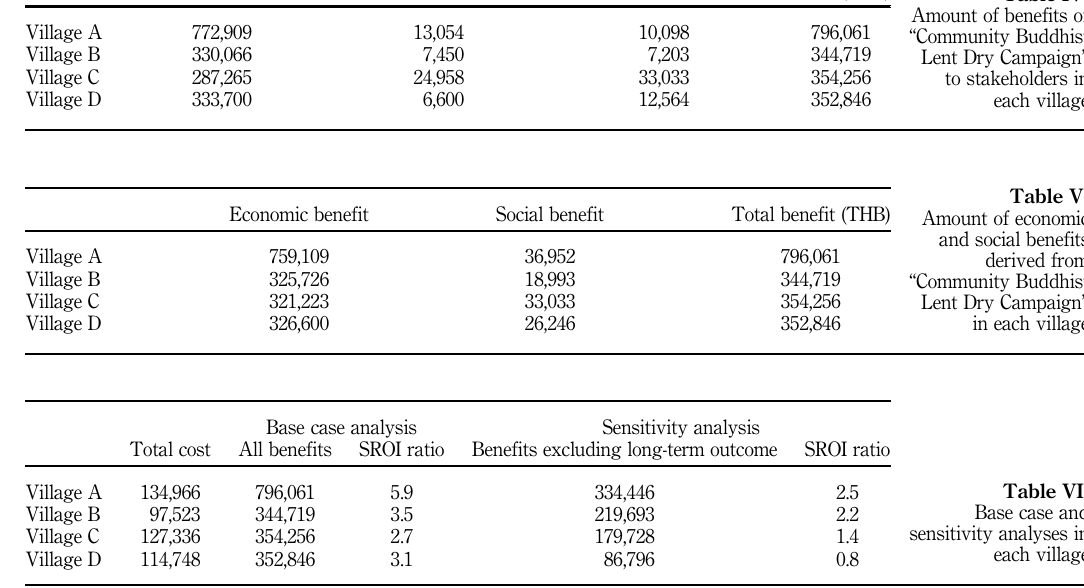
Table IV. Amount of benefits of “ Community Buddhist